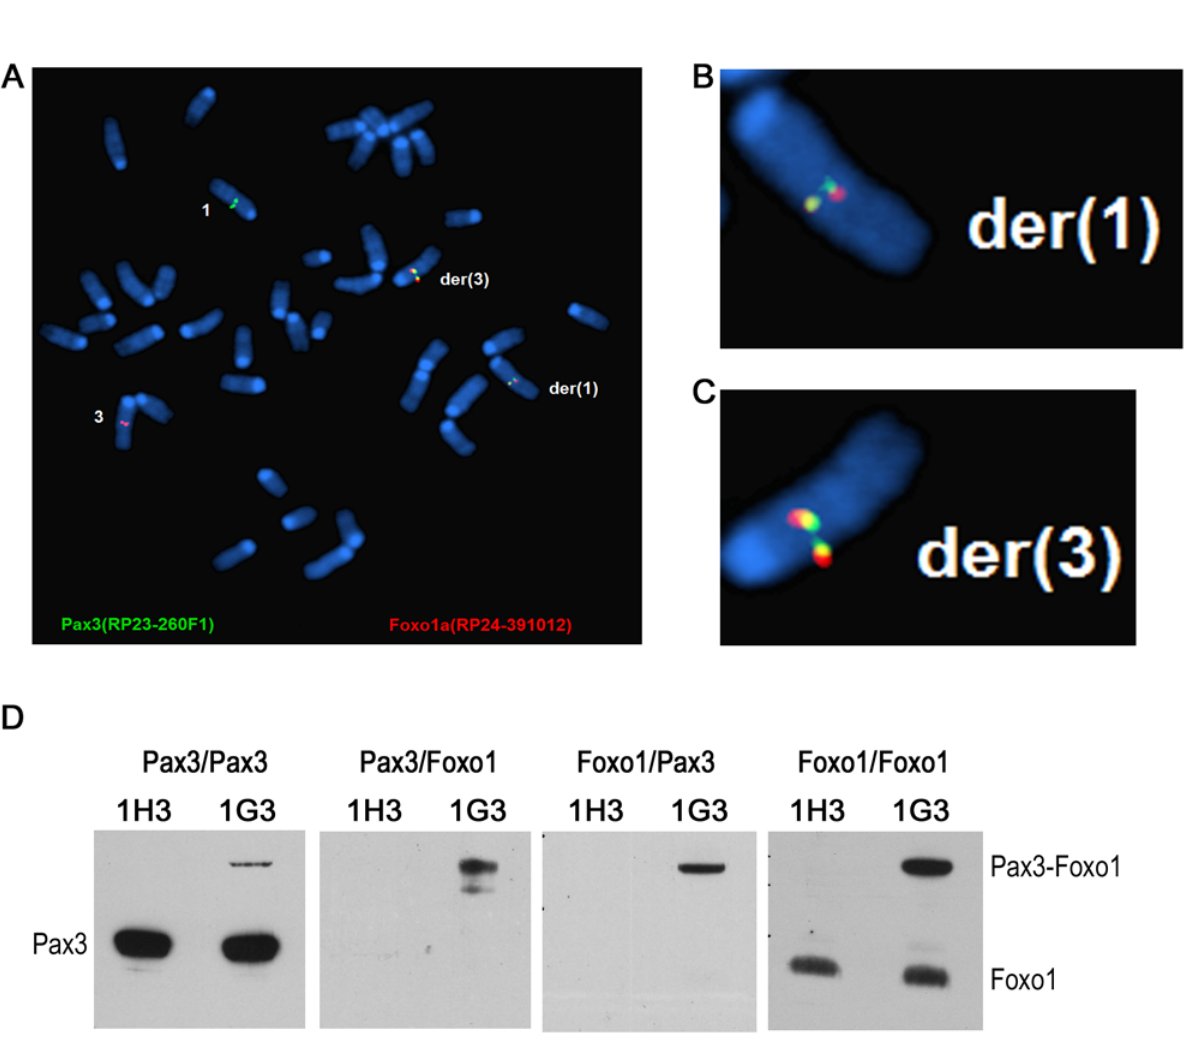
Figure 6. The reciprocal t(1;3) in myoblasts expresses Pax3-Foxo1 protein, which upregulates target gene expression. A-C. FISH analysis of an t (1;3)-enriched pool 1G3 myoblasts showing the reciprocal translocation. B and C show the magnified der(1) and der(3) chromosomes, respectively. D. Lysate of 1H3 (0%) and 1G3 [64% t(1;3)] myoblasts was immunoprecipitated with an anti-Pax3 antibody and immunoblotted with anti-Pax3 antibody (Pax3/Pax3) or anti-Foxo1 antibody (Pax3/Foxo1). The IP with anti-Foxo1 antibody was immunoblotted with anti-Pax3 antibody (Foxo1/Pax3) and an anti-Foxo1 antibody (Foxo1/Foxo1). The positions of the Pax3, Pax3-Foxo1 and Foxo1 bands are indicated.